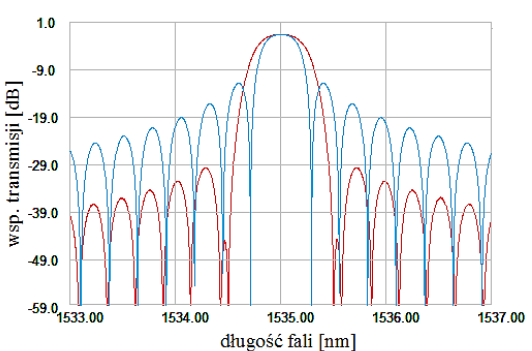
Fig. 7 . Comparison of Bragg fiber gratings characteristics without apodization – blue line and apodized Gauss function at а = 2 – red line.